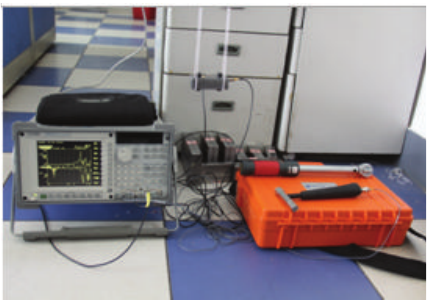
Figure 9: Experiment